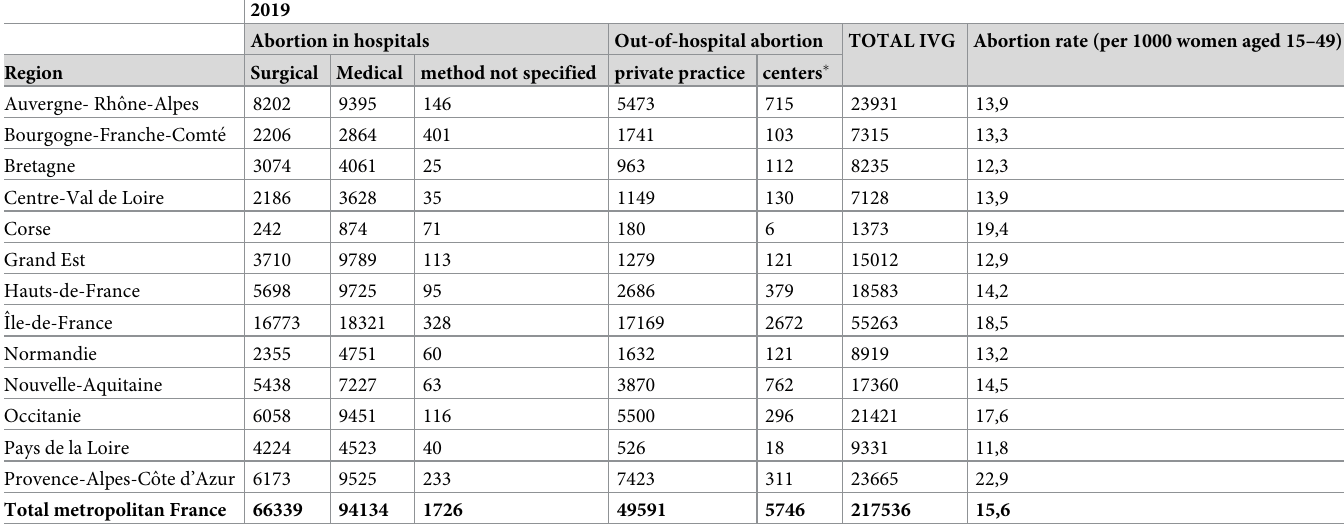
Table 1. Number of abortions by region of residence of the woman, place of abortion and method, metropolitan France,